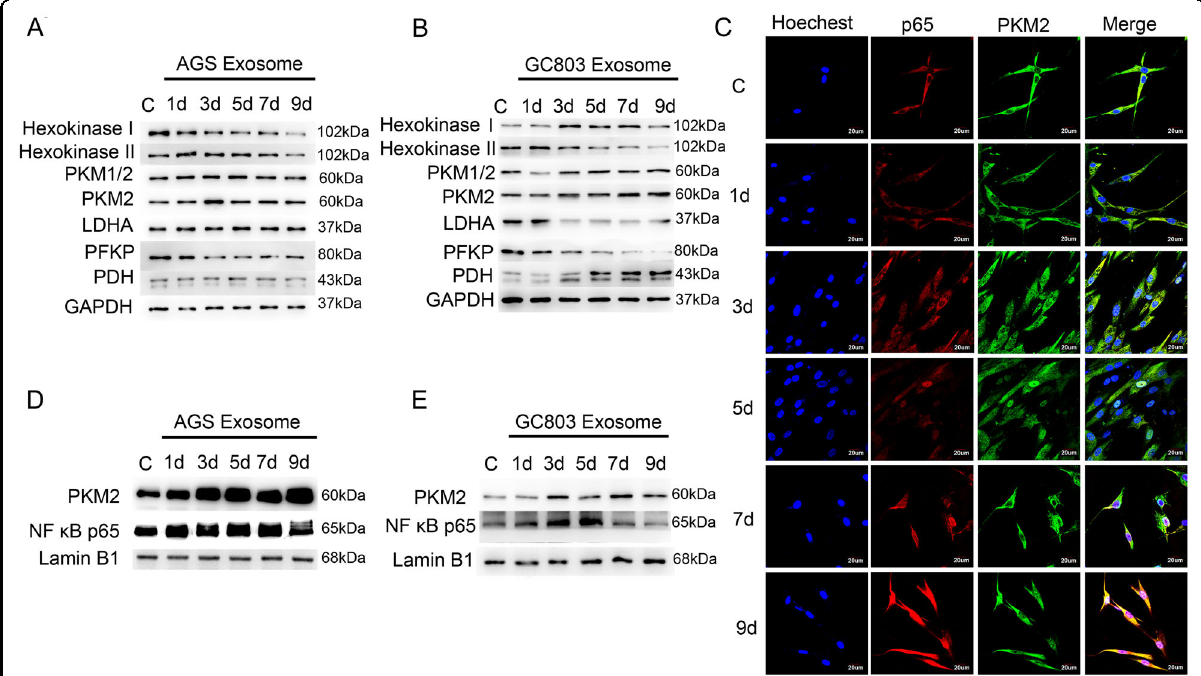
Fig. 3 PKM2 and P65 in the nucleus were simultaneously upregulated during the differentiation of MSCs into CAFs induced by gastric cancer exosomes. A , B The protein-level changes of glycolysis enzymes (Hexokinase I, Hexokinase II, PKM1/2, PKM2, LDHA, PFKP, and PDH) during the differentiation of MSCs into CAFs induced by AGS exosomes ( A ) or GC803 exosomes ( B ) were evaluated by western blot. C Confocal microscopy detected PKM2 and P65 expression in the nucleus during the differentiation of MSCs into CAFs induced by AGS exosomes. Blue: Nucleus (Hoechst 33342). Red: P65 (rhodamine). Green: PKM2 (Alexa Fluor 488. D , E Western blotting analysis detected PKM2 and P65 changes in the